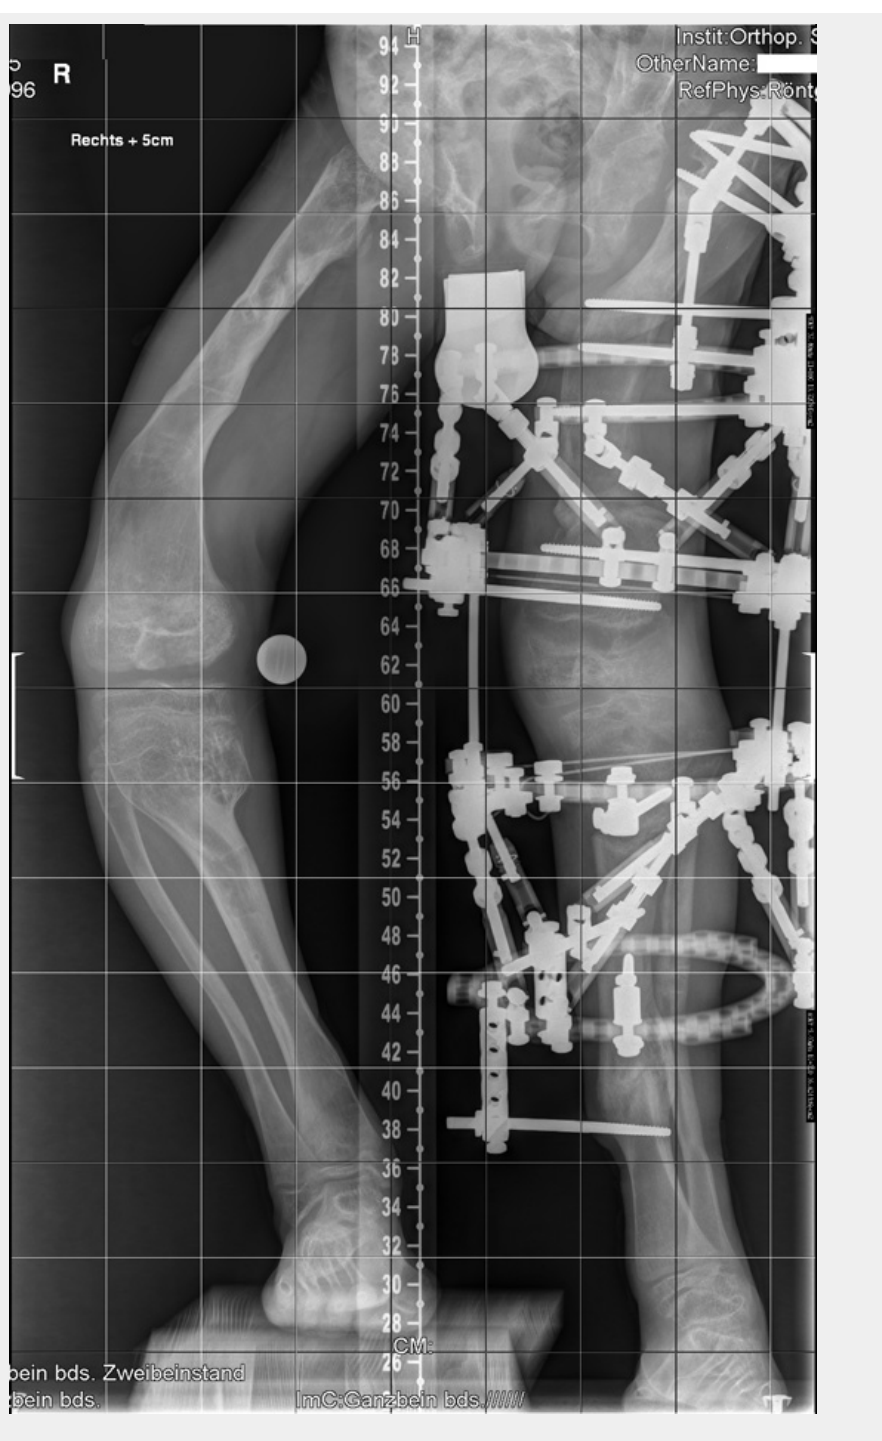
Figure 3 After performing a proximal and distal femoral osteotomy and a proximal tibial osteotomy on the left side, a Taylor Spatial Frame™ was